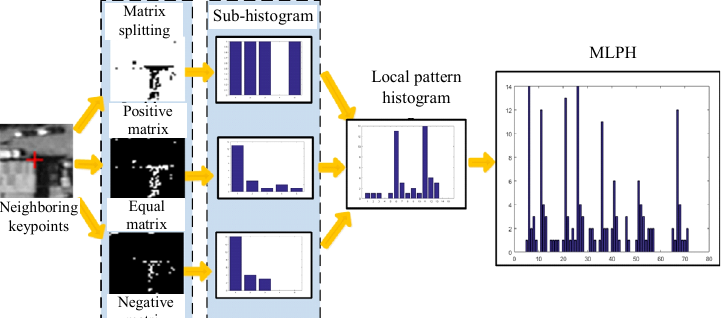
Fig. 3 Extracting MLPH features. From left to right, the panels show the original image, the matrix splitting procedure, the subhistograms derived from the split matrices, the local pattern histogram, and the MLPH, respectively. The local pattern histogram is formed by concatenating three subhistograms, and the subhistograms are computed based on (6) with B = 2 and K = 5. The MLPH is formed by concatenating the local pattern histograms of different scales, and the local pattern histograms are computed based on (7) with T = 2 and M = 5.